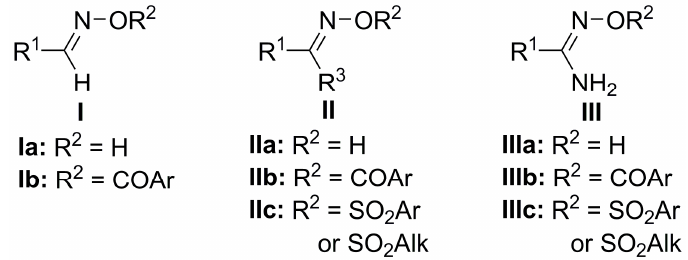
Figure 1. General structures of aldoximes ( I ), ketoximes ( II ); amidoximes ( III ); and their